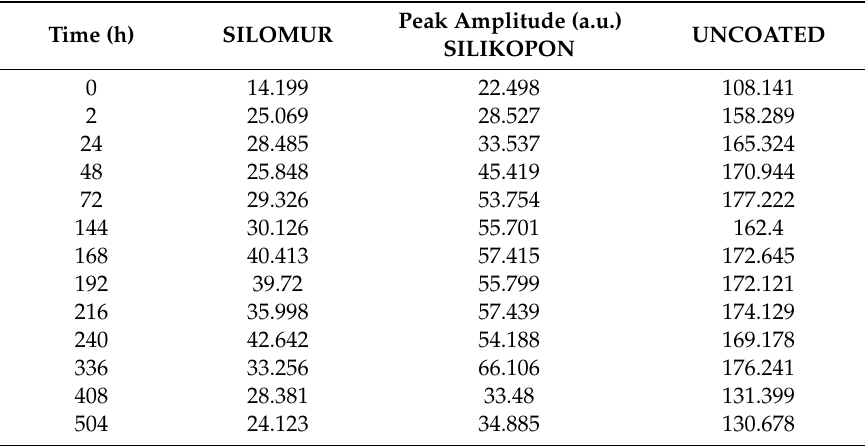
Figure 10. Correlation graphs of percentage variations of areas and weights for uncoated samples and coated by the Silomur or Silicopon. Table 3. Amplitude of the -OH